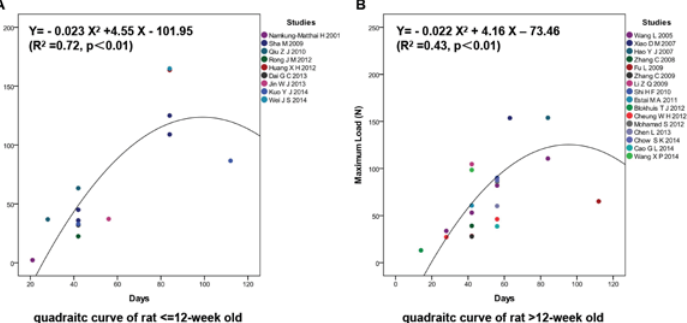
Fig 6. Osteoporotic fracture healing was not delayed in rats < = 12 weeks old at ovariectomy. (A) In the < = 12-week-old group, the predicted fracture healing time was 98.91 d and the predicted maximum load was 123.05 N. (B) In the > 12-week-old group, the predicted fracture healing time was 94.55 d and the predicted maximum load was 123.20